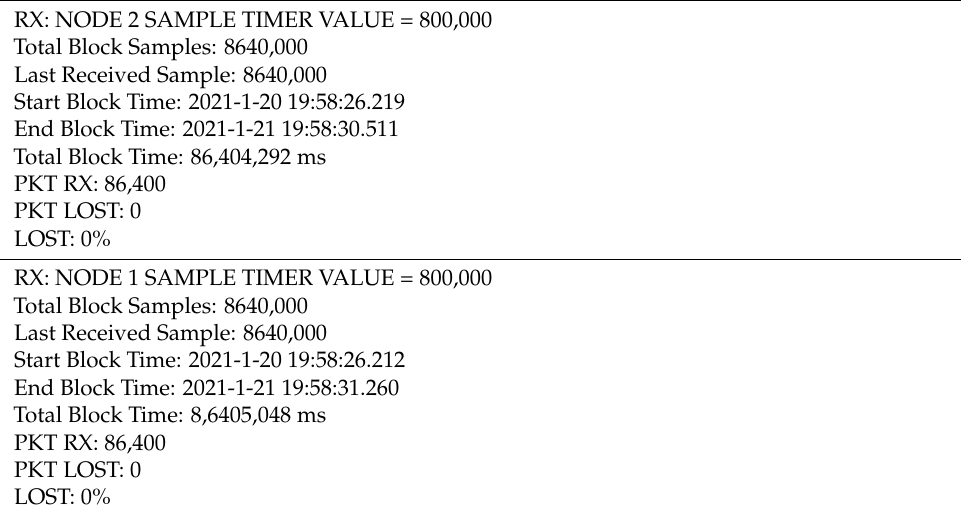
Table 2. Results of 24h register calibration with default values.